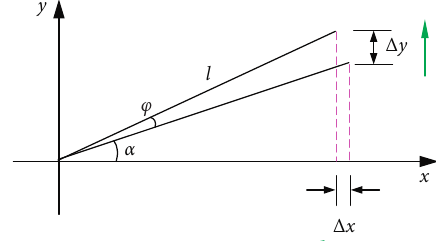
Figure 9: Relationship between segmental rotation and the co- ordinates of the